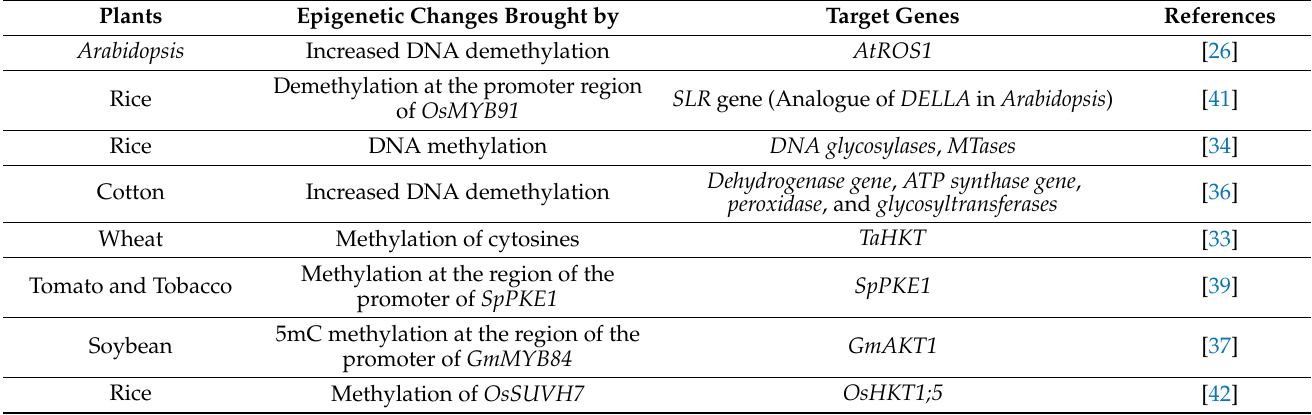
Table 1. DNA methylations mediated epigenetic changes under salt stress. A summary of recently reported modifications and their corresponding genes are enlisted